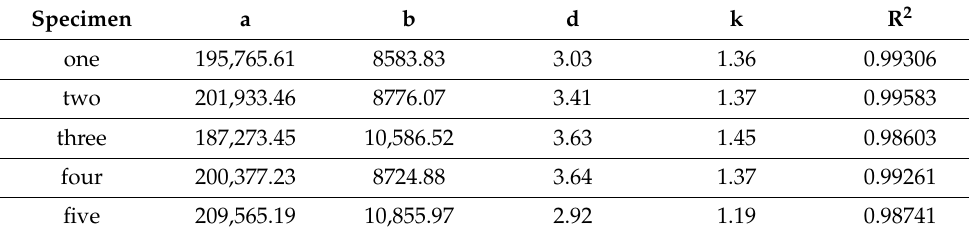
Table 3. Curve fitting results.